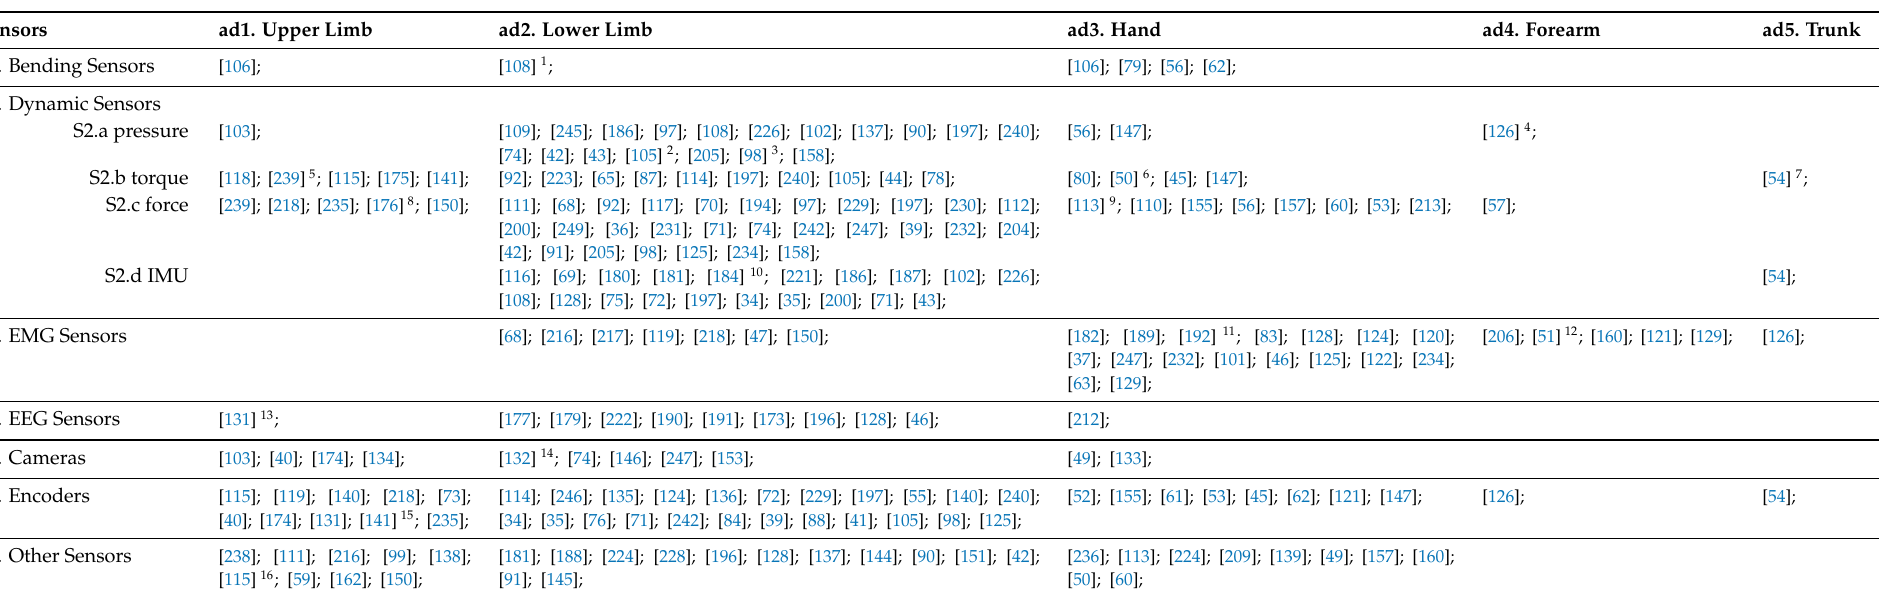
Table A4. Cross analysis of the paper distribution of sensors vs. anatomical